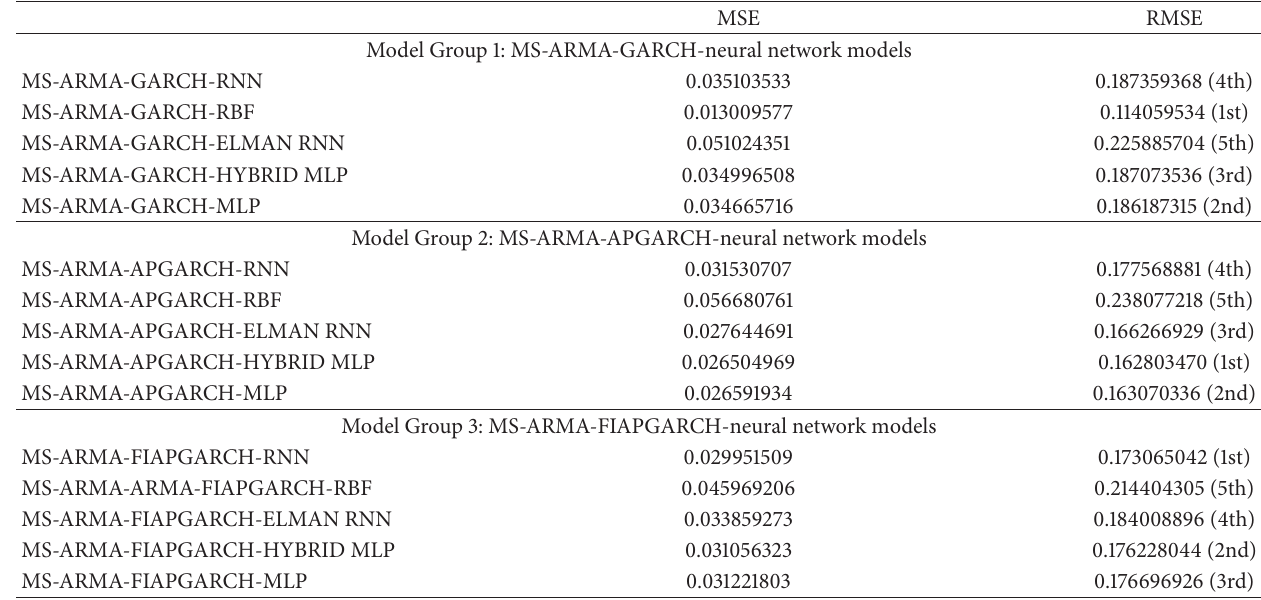
Table 4: Markov switching GARCH neural network models: training results.